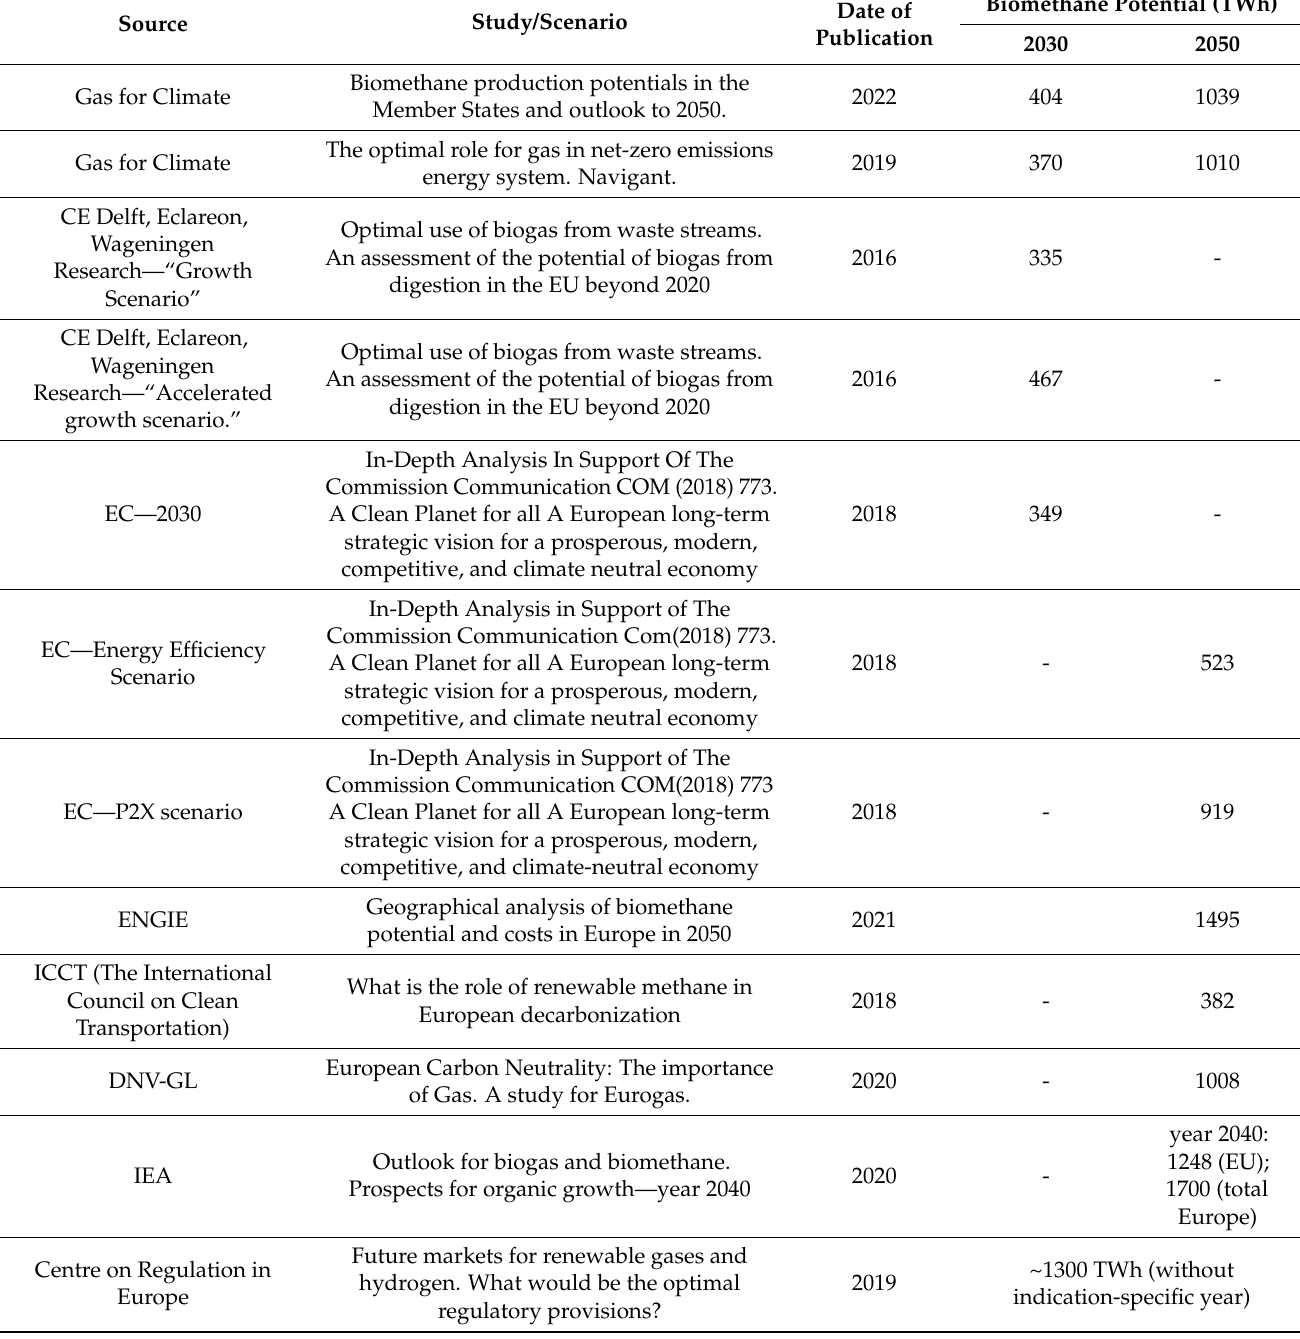
Table 4. Biomethane production potential in 2030 and 2050 summary of available